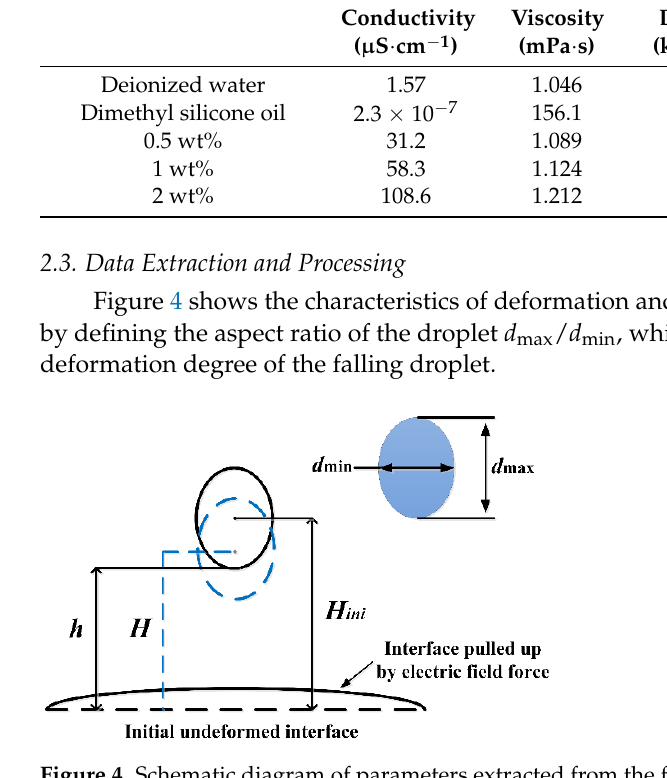
Table 1. Physical properties of deionized water and silicon oil.